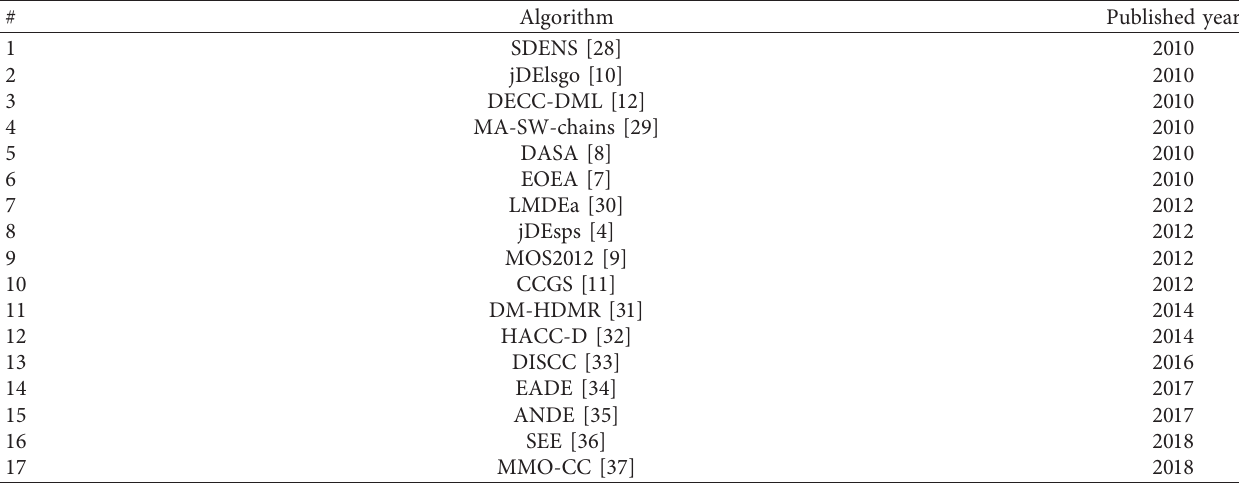
Table 4: Compared algorithms using CEC2010.